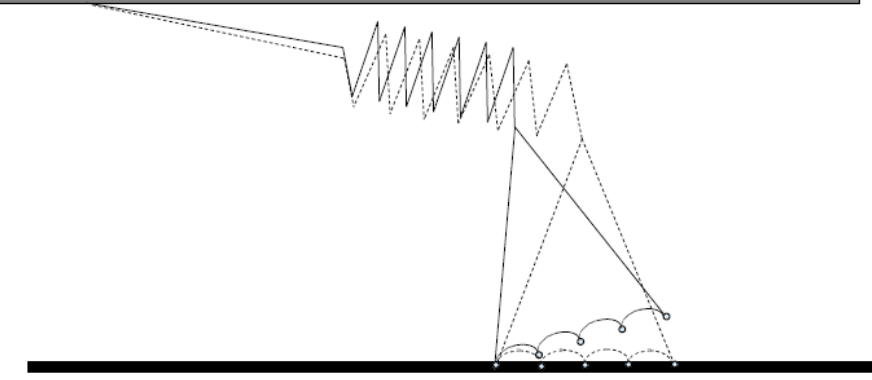
Figure 5. Force generation by myosin on actin as tentatively depicted in [141]. A larger part of the myosin head swings while stretching an elastic element in series and, step-wise, increasing its strength of binding to actin.